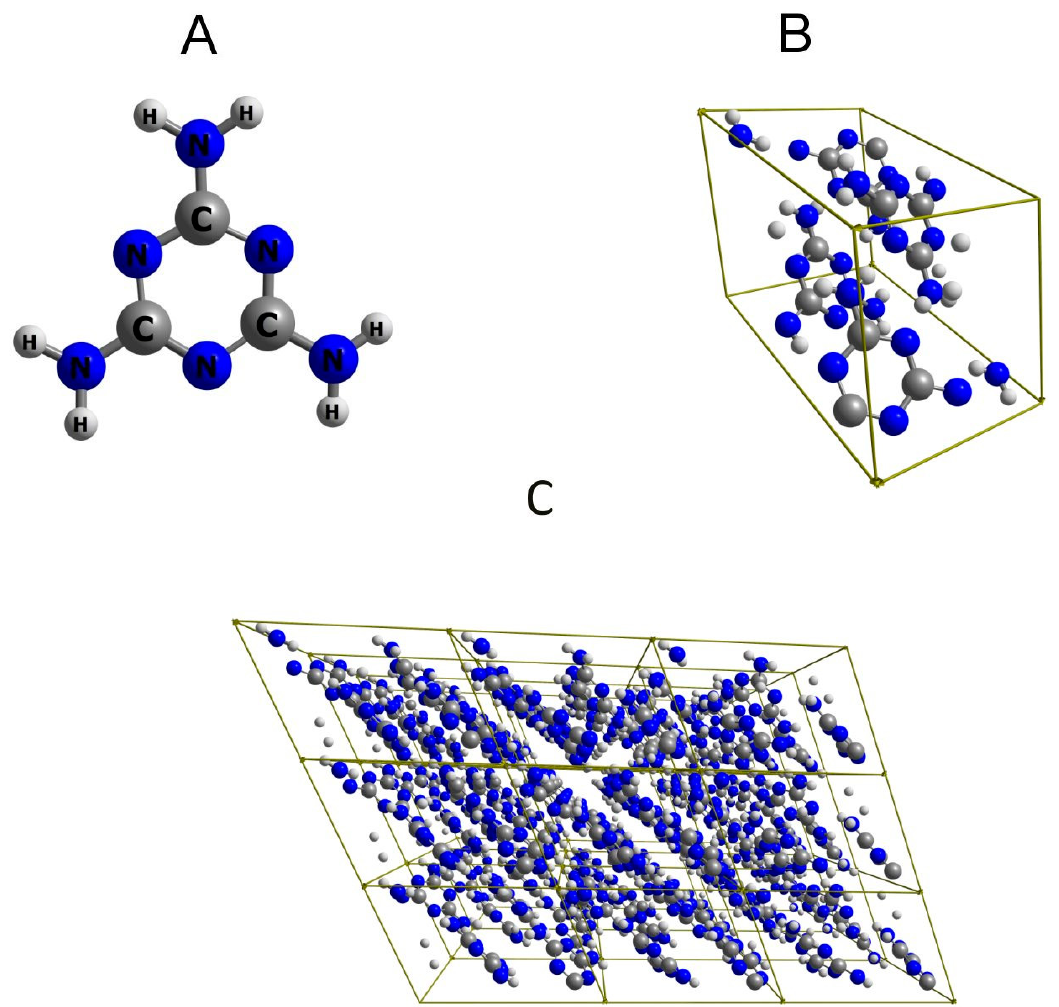
Figure 1. Molecular structure of melamine. ( A ) single molecule; ( B ) the content of a unit cell; ( C ) 3 × 3 × 3 supercell. The structure after optimization (B3LYP \ Gatti) is presented in Figure S1 (Supplementary Materials).